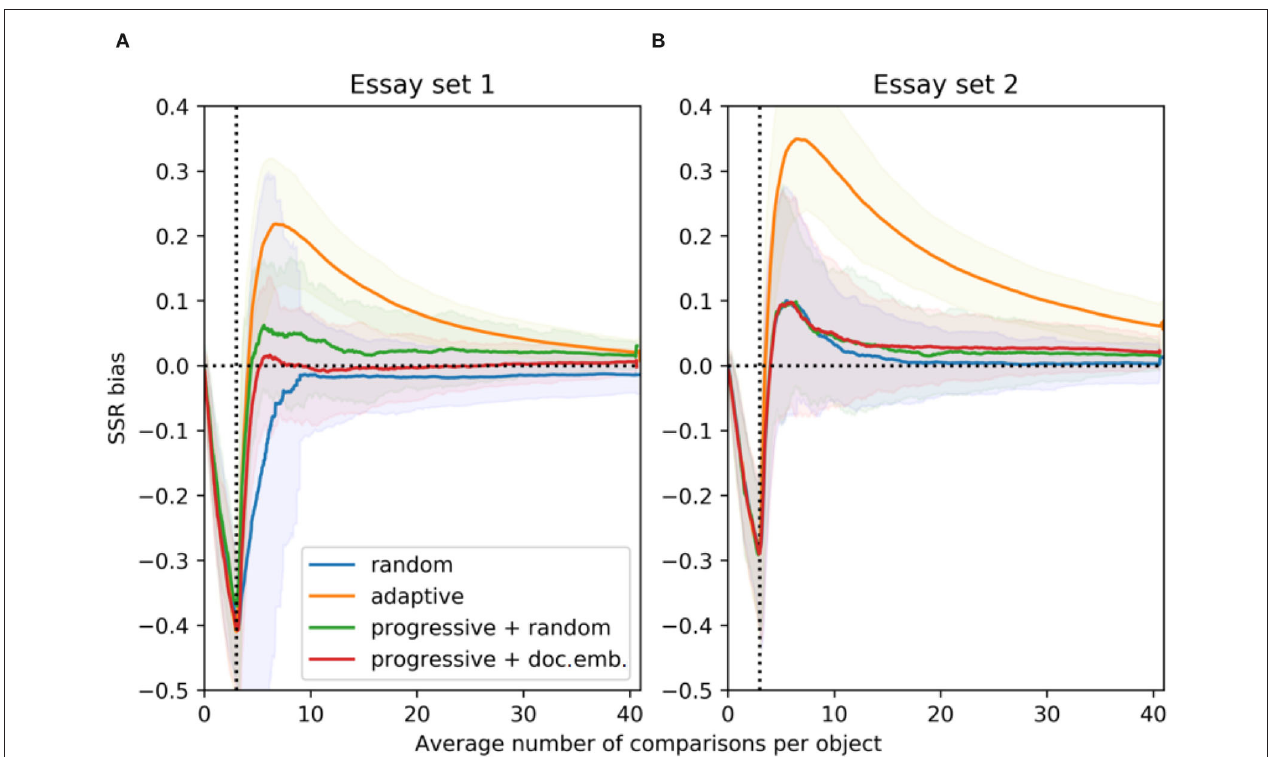
FIGURE 4 | For essay set 1 ( A , N 1 = 141) and 2 ( B , N 2 = 150), SSR bias resulting from the selection rules: random (CJ), adaptive (ACJ) and a progressive selection with a random and a similarity component using document embeddings (100 simulations). The solid lines indicate the mean values and the transparent bands indicate the 95% point-wise confidence